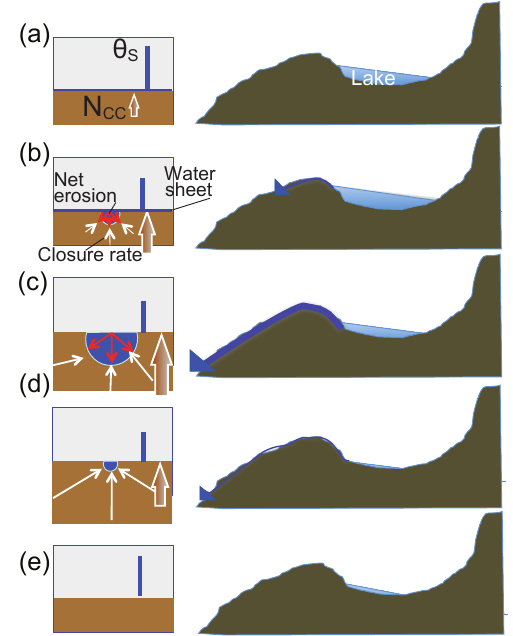
Figure 2. Schematic diagram showing the various stages of lake ac- tivity (right panels) and the corresponding evolution of the channel (left panels). Red arrow denotes net erosion rate, white arrow de- notes closure rate, brown arrow denotes canal effective pressure, and blue bar indicates hydropotential in the distributed system: (a) initially the lake is filling and no outflow takes place; (b) as lake level increases, effective pressure differences between lake and seal allow for some water to escape via a distributed system (a.k.a. “water sheet”); (c) as the distributed system grows, a low pressure channel is eroded that begins to draw water from the surroundings; (d) while the low pressure channel allows for the lake to drain be- low the level at which outflow was initiated, as pressure lowers, sediment creeps inward; and (e) the channel contracts until its flow is negligible and the lake